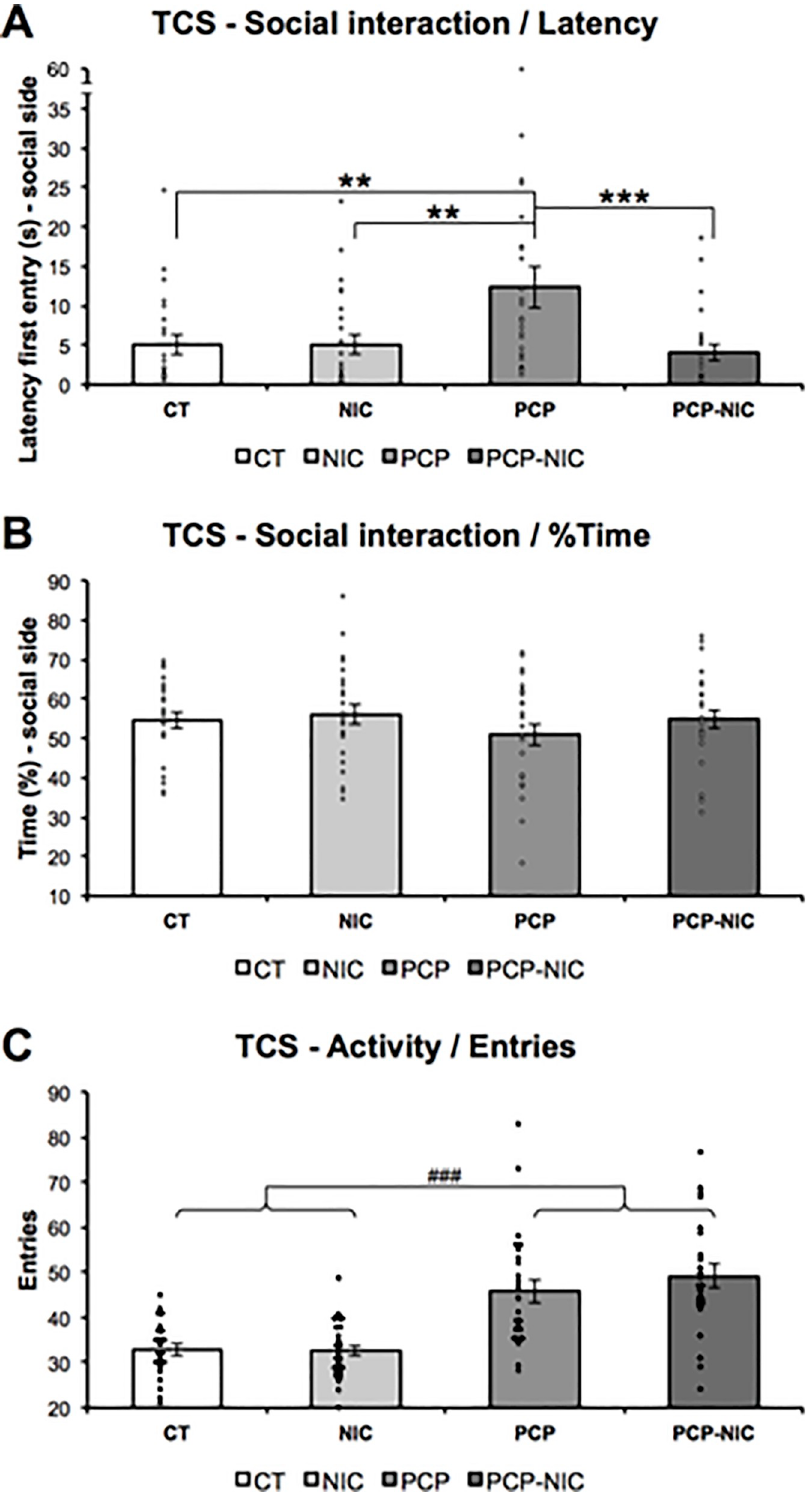
Fig 4. Effects of phencyclidine treatment, nicotine history and the combined insults on adolescent mice’s (A) time to first entry into social side, (B) percent time on social side and (C) activity, as assessed in the three-chamber sociability test. CT: Control group ( ♀ = 11, ♂ = 12); NIC: Nicotine-exposed group ( ♀ = 12, ♂ = 14); PCP: